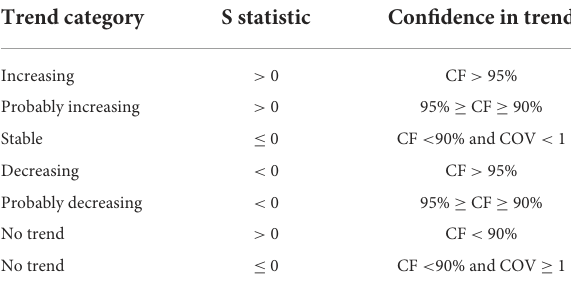
TABLE 2 Mann-Kendall trend categories after Connor et al. (2012). Trend category S